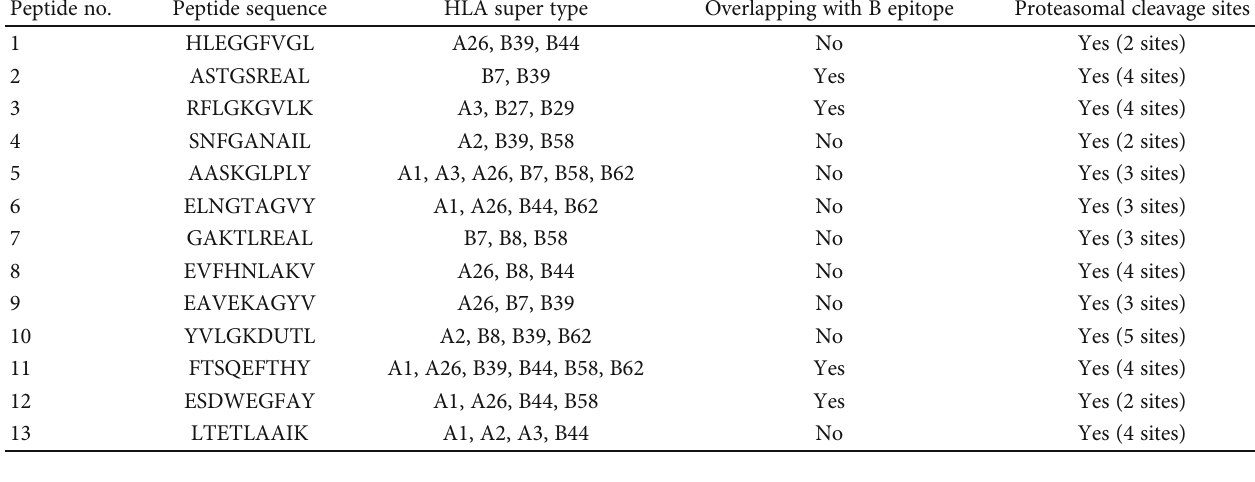
Table 2: Cytotoxic T lymphocyte epitopes for di ff erent HLA supertypes predicted in NT H. in fl uenzae enolase. Peptide no.